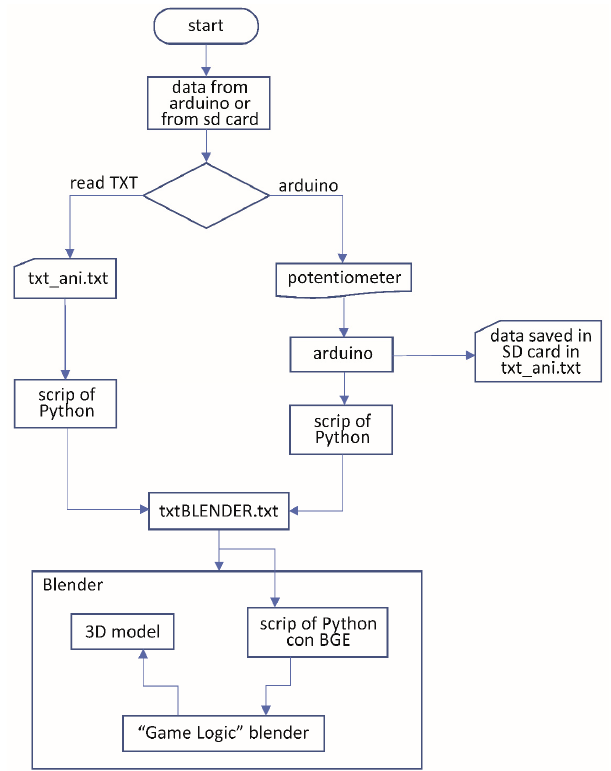
Table 1. Relative values of the sensors.